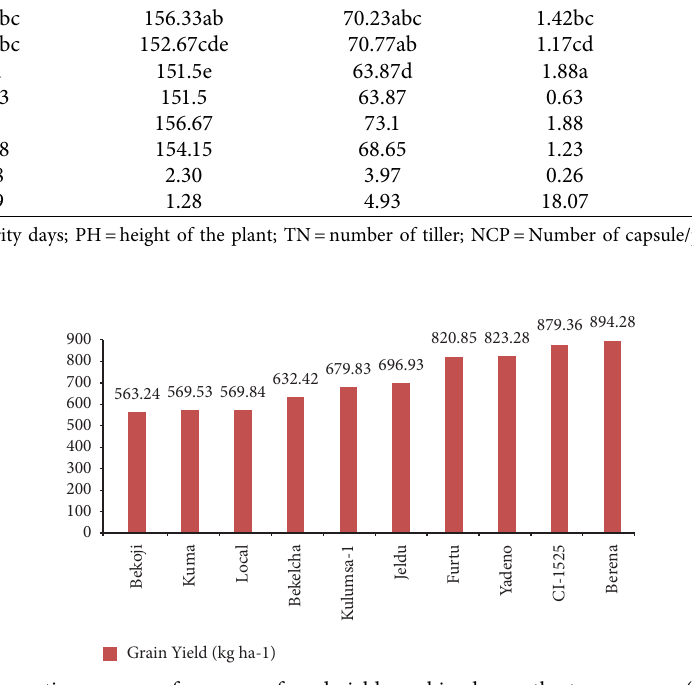
Table 2: Mean performance of seed yield and related traits of linseed varieties combined over the two cropping seasons (2019 & 2020). Varieties DF DM PH (cm) Kulumsa-1 Bekelcha 87.67d Yadeno Jeldu